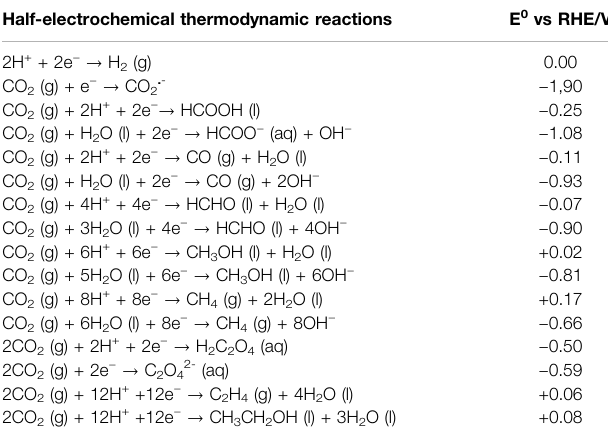
TABLE 1 | Selected CO 2 reduction processes and the corresponding standard redox potentials E 0 for aqueous solutions (Francke et al., 2018). Half-electrochemical thermodynamic